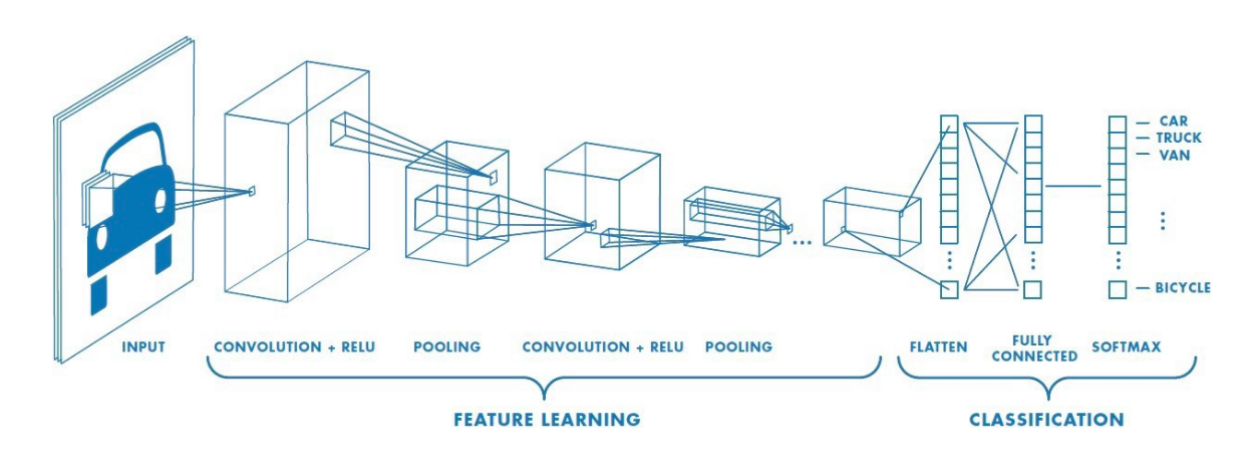
Figure 1. CNN architecture